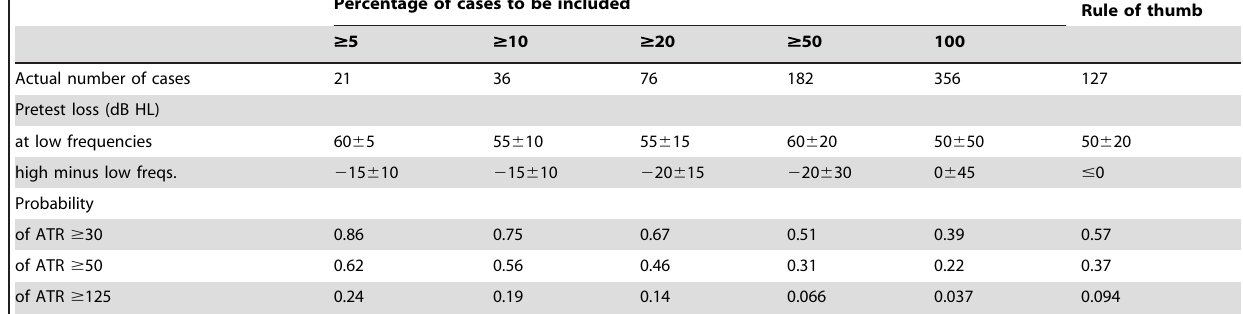
Percentage of cases to be